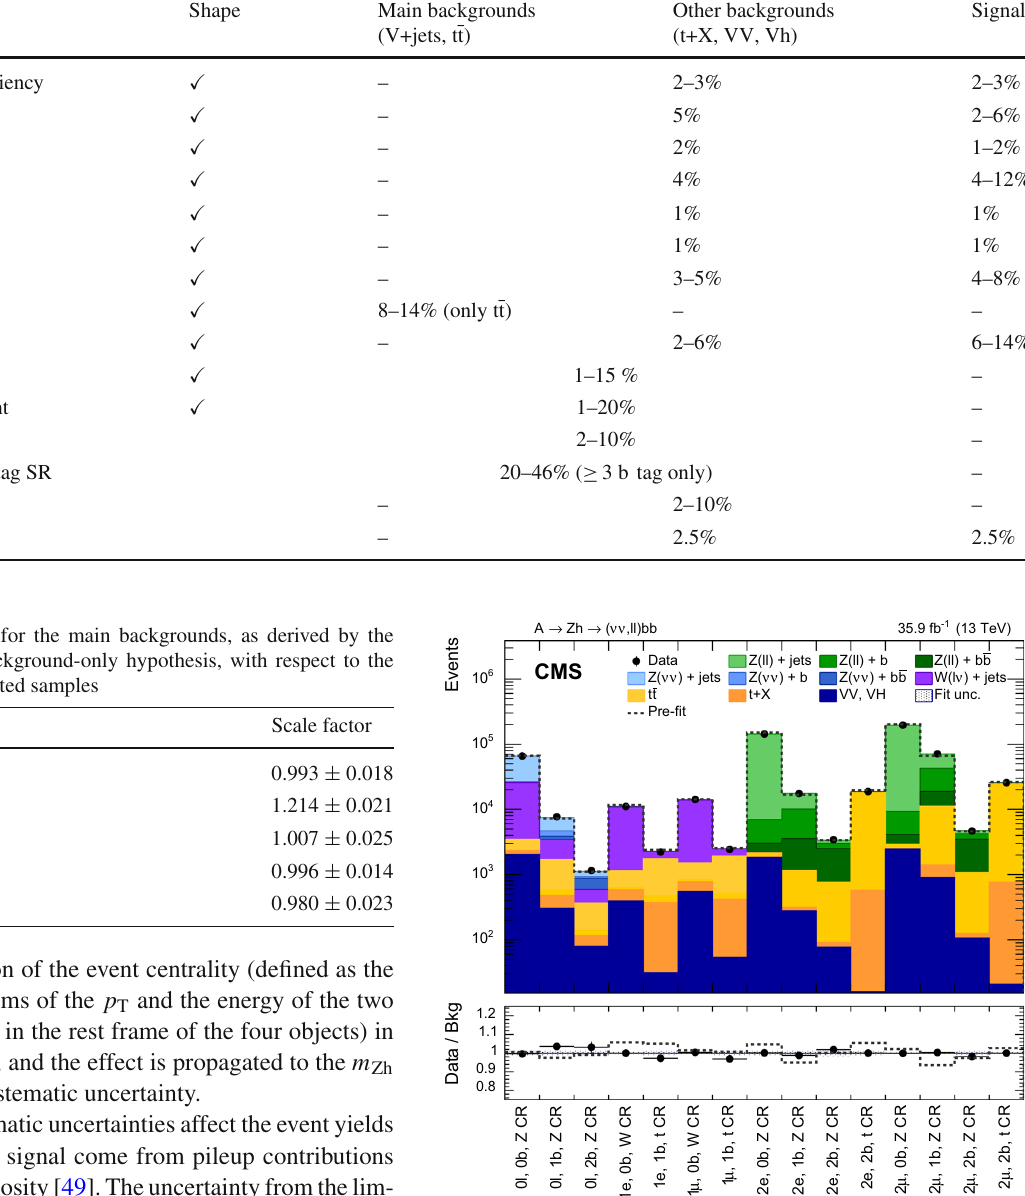
pretation [51–53]. The asymptotic approximation [54] of the modified frequentist CL s criterion [51,52] is used to deter- mine limits on the signal cross section at 95% confidence level (CL). The background-only hypothesis is tested against the combined signal+background hypothesis in the nine